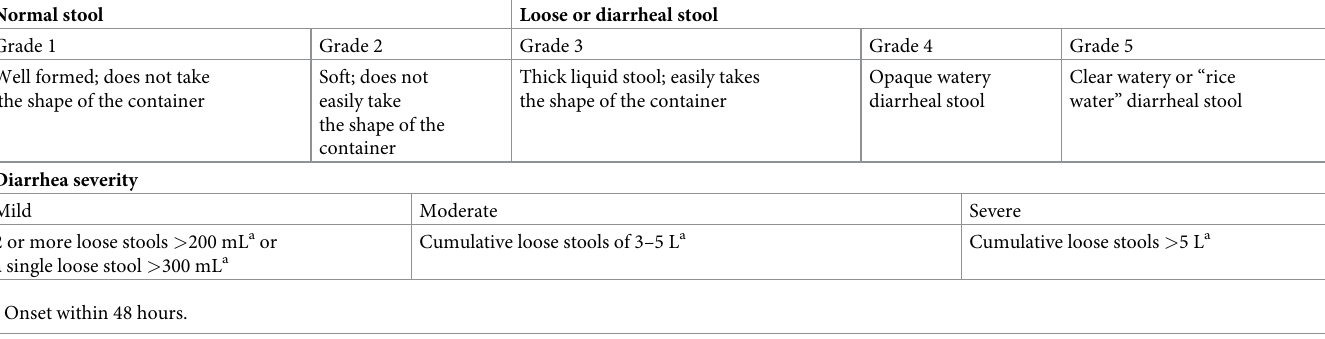
Table 1) divided by the number of hours between the start of study drug administration and the initiation of antimicrobial therapy. A maximum of two stool samples or rectal swabs were collected and examined daily for the presence of V . cholerae prior to the start of antimicrobial therapy. Quantitative cultures were performed by inoculating stool specimens directly onto